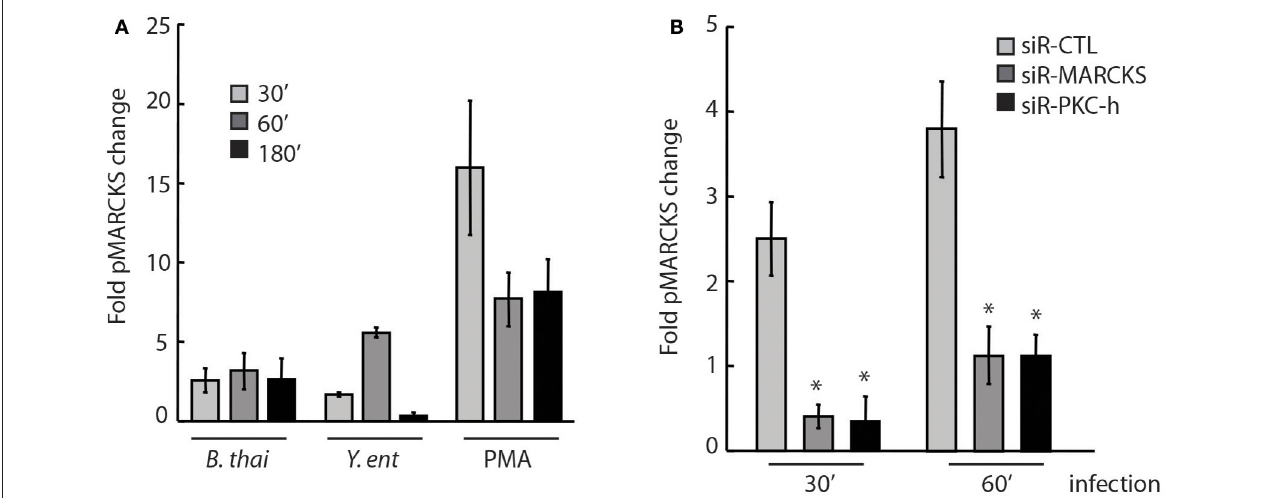
FIGURE 3 | PKC- η is involved in host MARCKS phosphorylation upon bacterial infection (A) A549 cells were infected with Bt CDC2721121 at MOI 50 or Y. enterocolitica WA at MOI 20. After the indicated times, cells were lysed and levels of phosphorylated Ser152/156 in the MARCKS effector domain (pMARCKS) were quantified using the PathScan ELISA kit and compared to uninfected A549 cells. Cells were also treated with 100 nM PMA as a positive control. In all samples, pMARCKS levels were normalized to the total MARCKS protein levels. The average and standard deviation from three independent experiments are shown. (B) A549 cells were treated with 25 nM siRNA against MARCKS, PKC- η , or non-targeting control (CTL) for 72 h prior to infection with Bt CDC2721121. At the indicated time, cells were lysed and the levels of pMARCKS were quantified as fold change relative to uninfected A549 cells. The average and standard deviation from three independent experiments are shown. The “*” denotes statistical significance ( p < 0.05) for fold pMARCKS change in samples treated with siRNA to MARCKS or PKC- η , compared to non-targeting siRNA samples